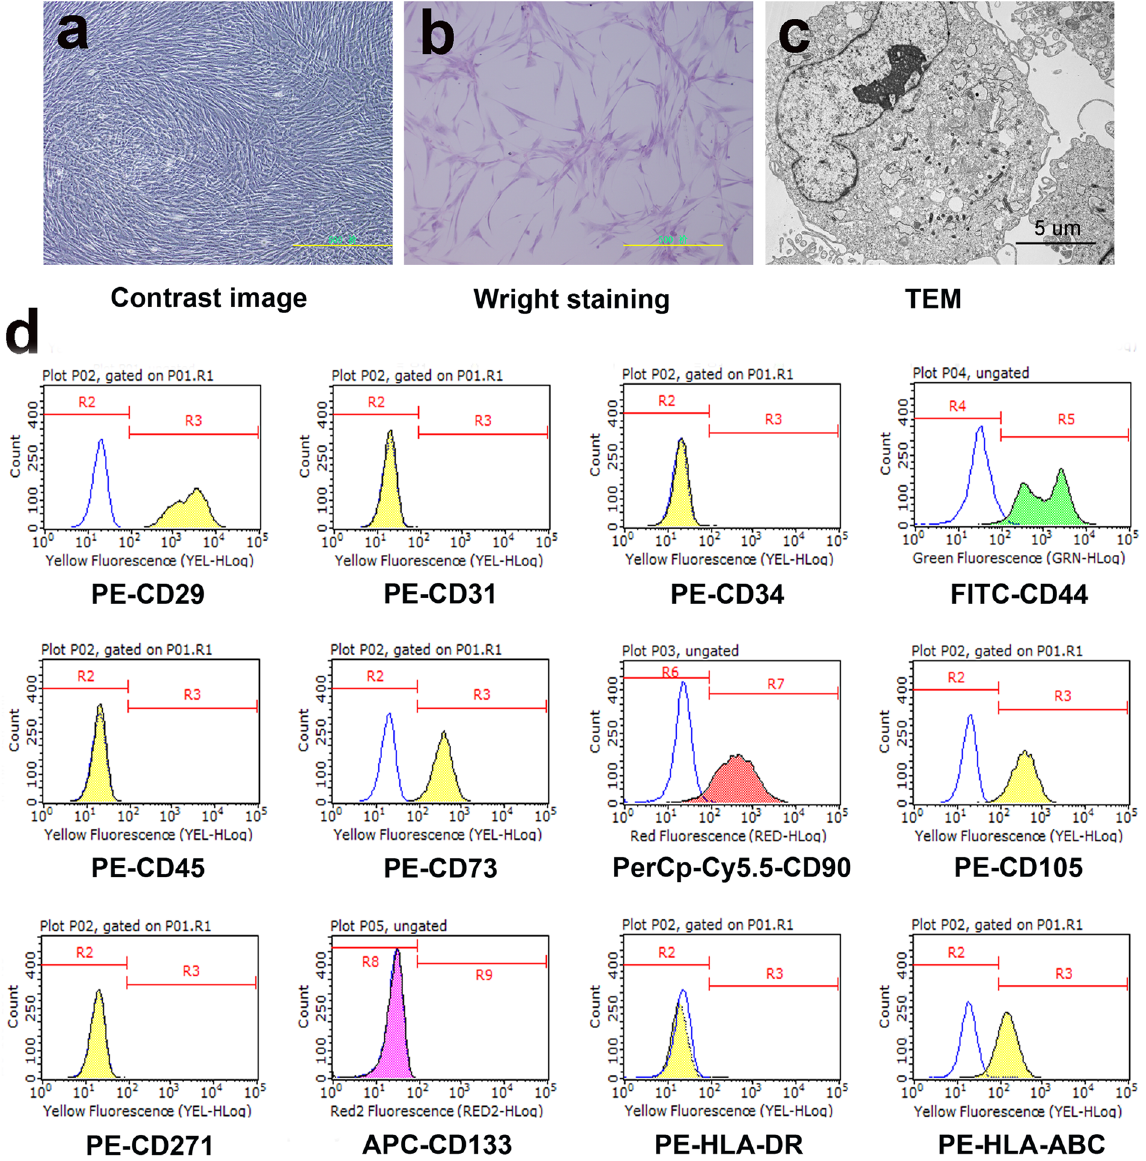
Figure 1. Typical characteristics of huMSCs. ( a , b ) HuMSC morphology was polygonal, swirling and fibroblast-like ( × 100 magnification). ( b ) Wright staining. ( c ) TEM showed that the connection between huMSCs primarily depended on microvilli contact, whilst tight junctions were occasionally visible. ( d ) HuMSC expression of CD29, CD44, CD73, CD90, CD105 and HLA-ABC was visibly high. However, the expression CD31, CD34, CD45, CD133, CD271 and HLA-DR was negative; n =